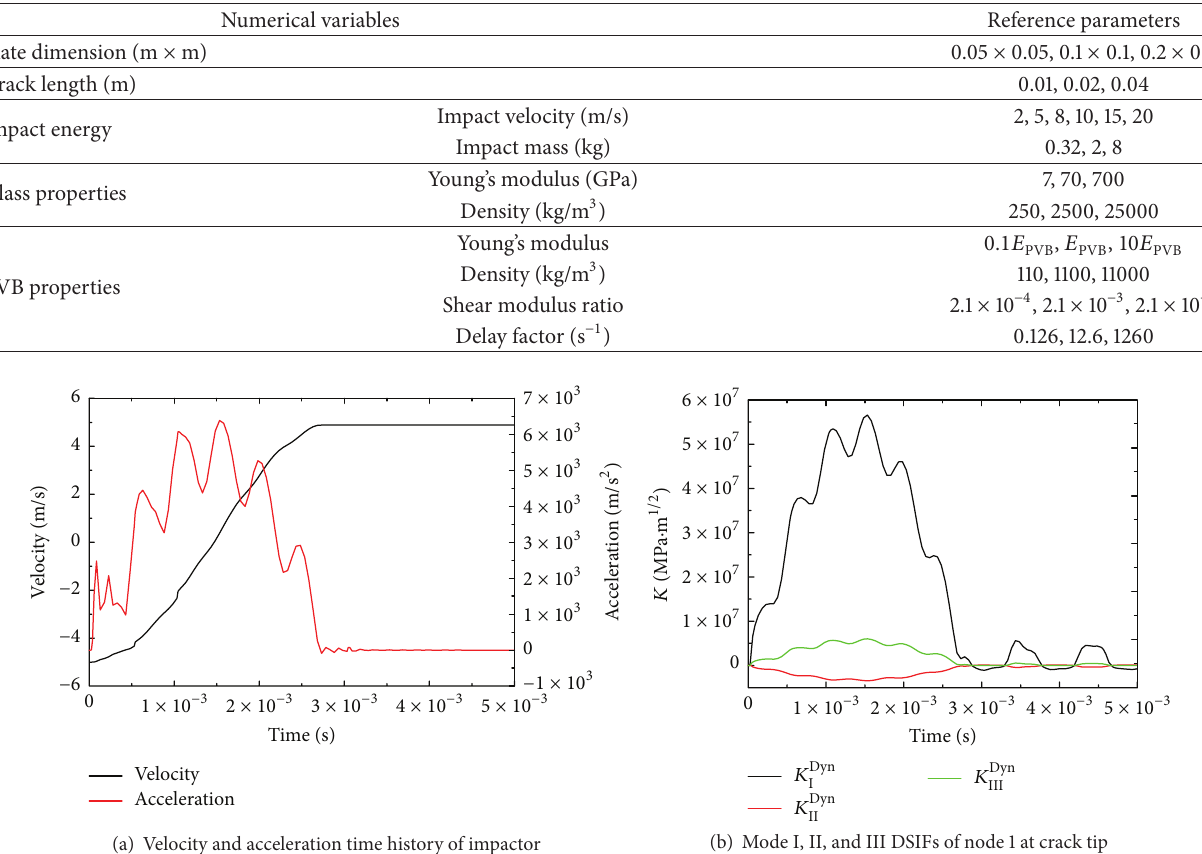
Figure 6: Simulation results with the impact velocity of 5m/s and crack length of 0.02